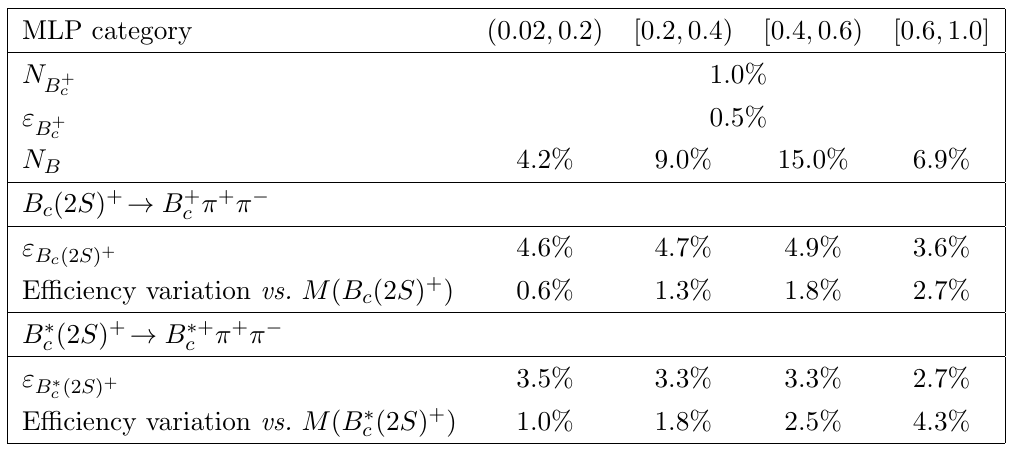
Table 2. Summary of the systematic uncertainties entering the upper limit calculation for the four MLP